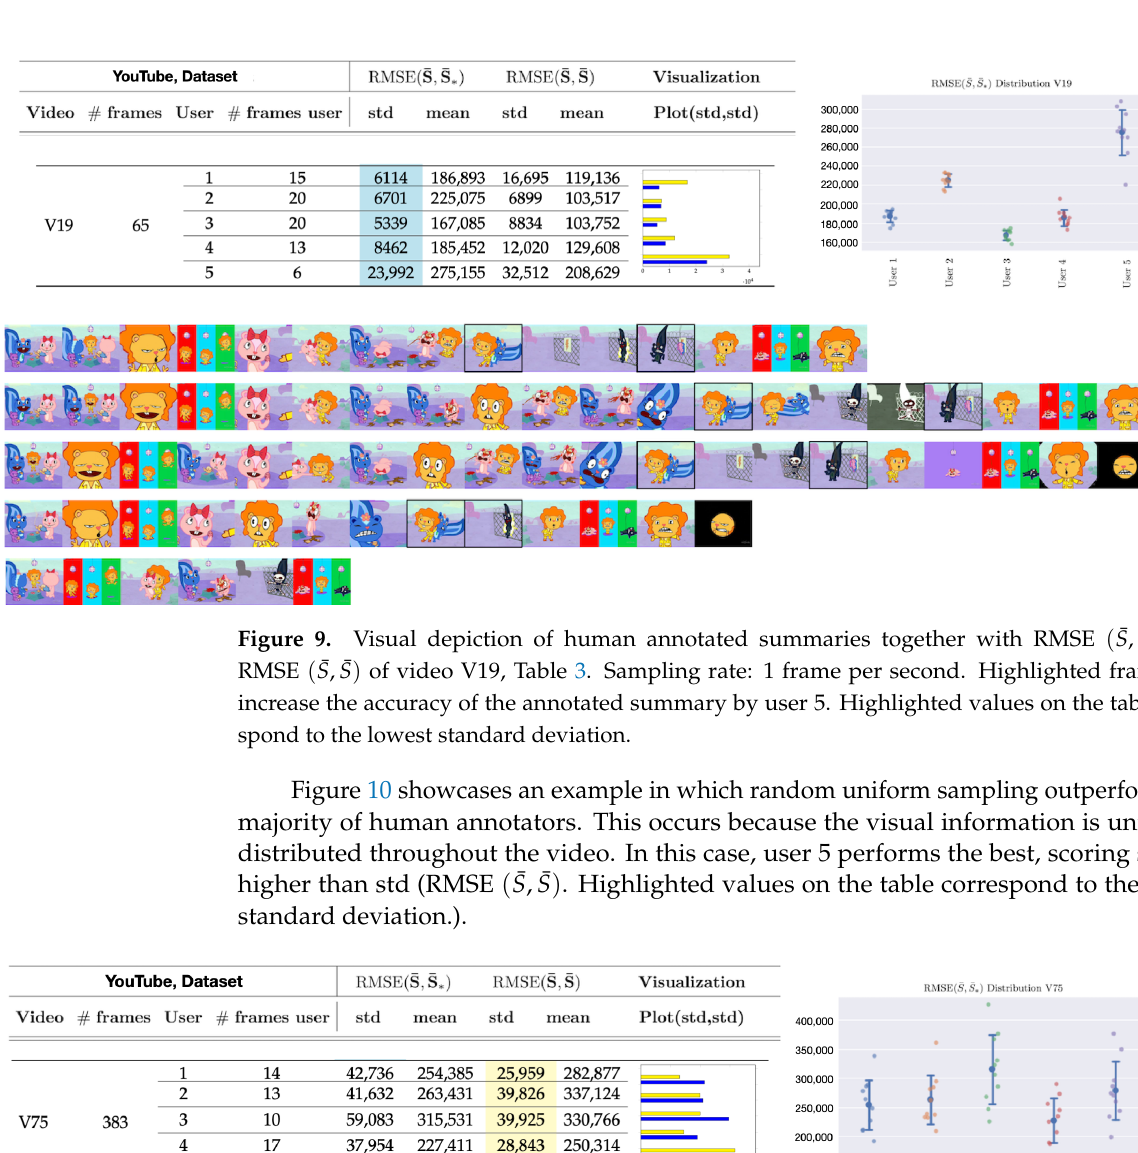
Figure 9. Visual depiction of human annotated summaries together with RMSE ( ¯ S , ¯ S RMSE ( ¯ S , ¯ S ) of video V19, Table 3. Sampling rate: 1 frame per second. Highlighted frames can increase the accuracy of the annotated summary by user 5. Highlighted values on the table corre- spond to the lowest standard deviation.